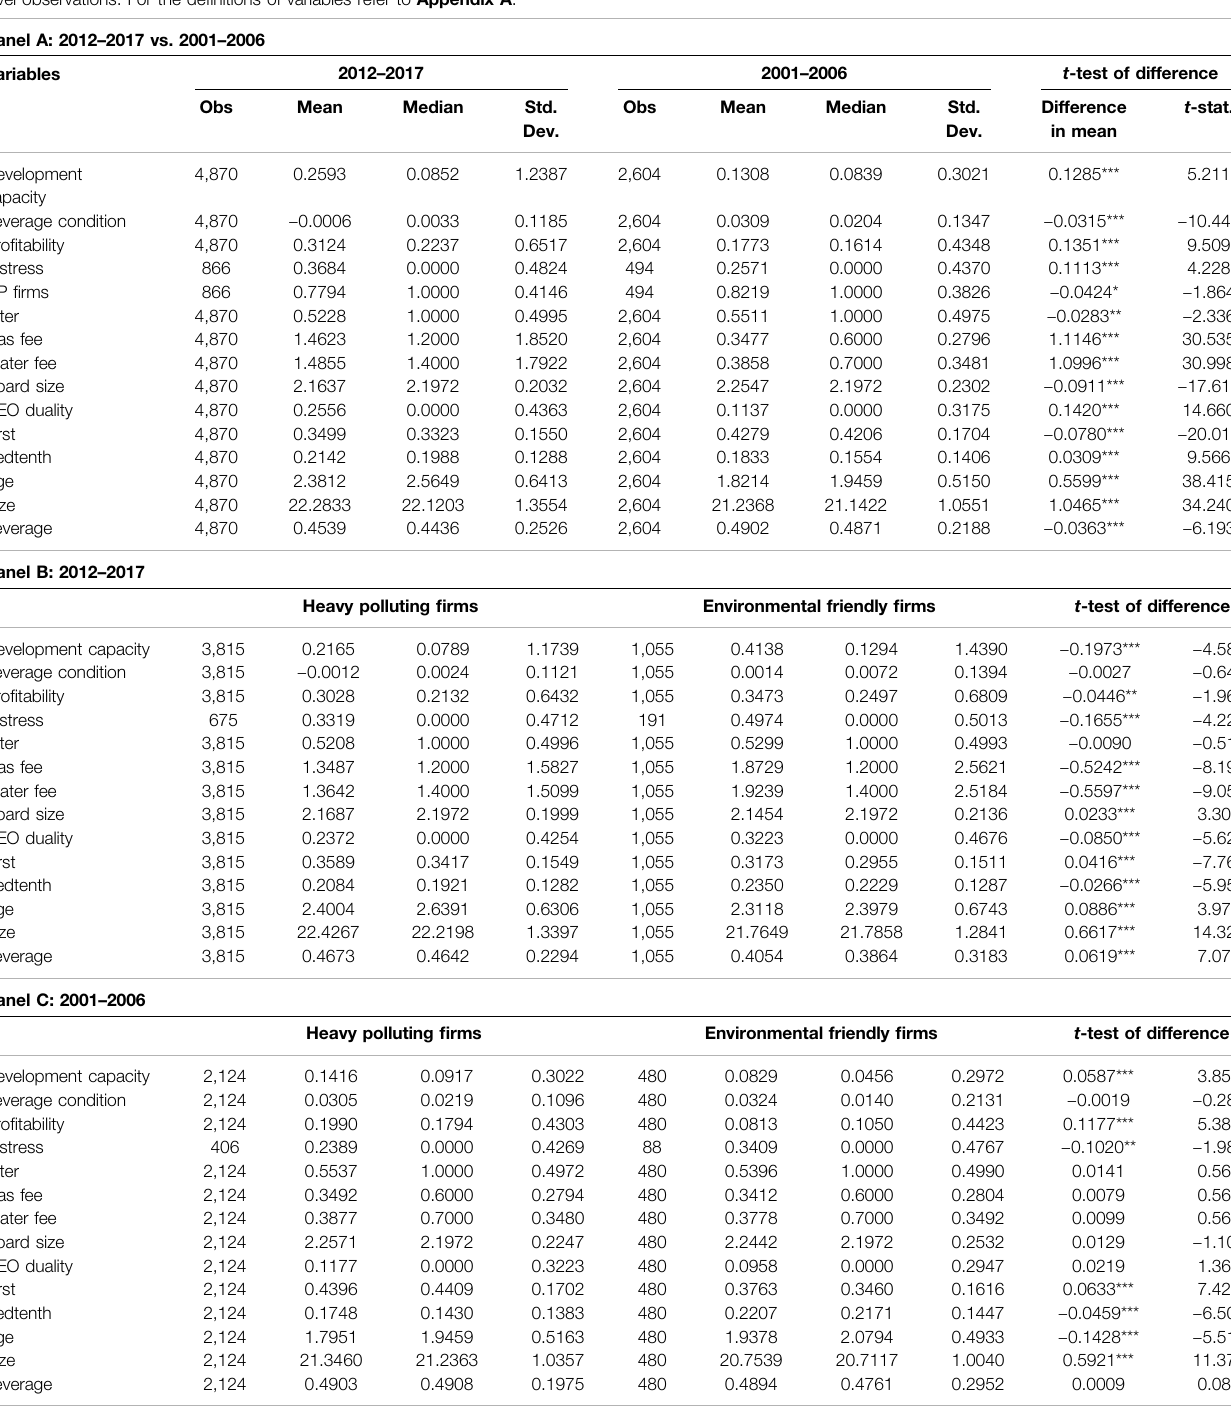
TABLE 1 | Summary statistics. Thistablepresentsthesummarystatisticsofmainvariables.The fi nancialdataisextractedfromtheCSMARdatabase.Thestudyincludestwoseparatesampleperiods, namely2012 – 2017and2001 – 2006.Thestatisticsofmostvariablesarebasedon fi rm-yearobservations,exceptingthatforDistressandHPFirms,whicharebasedon fi rm- level observations. For the de fi nitions of variables refer to Appendix A